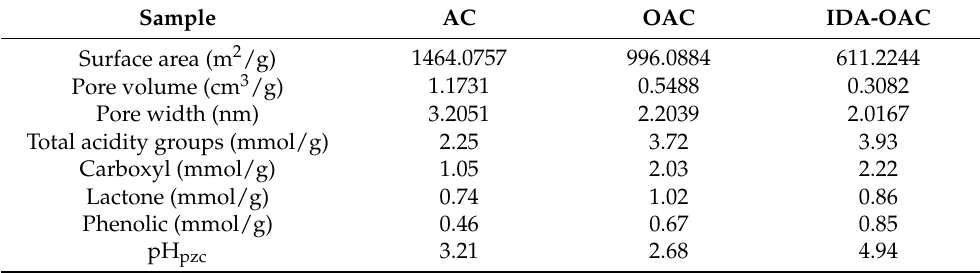
Table 2. Physicochemical parameters of AC, OAC, and